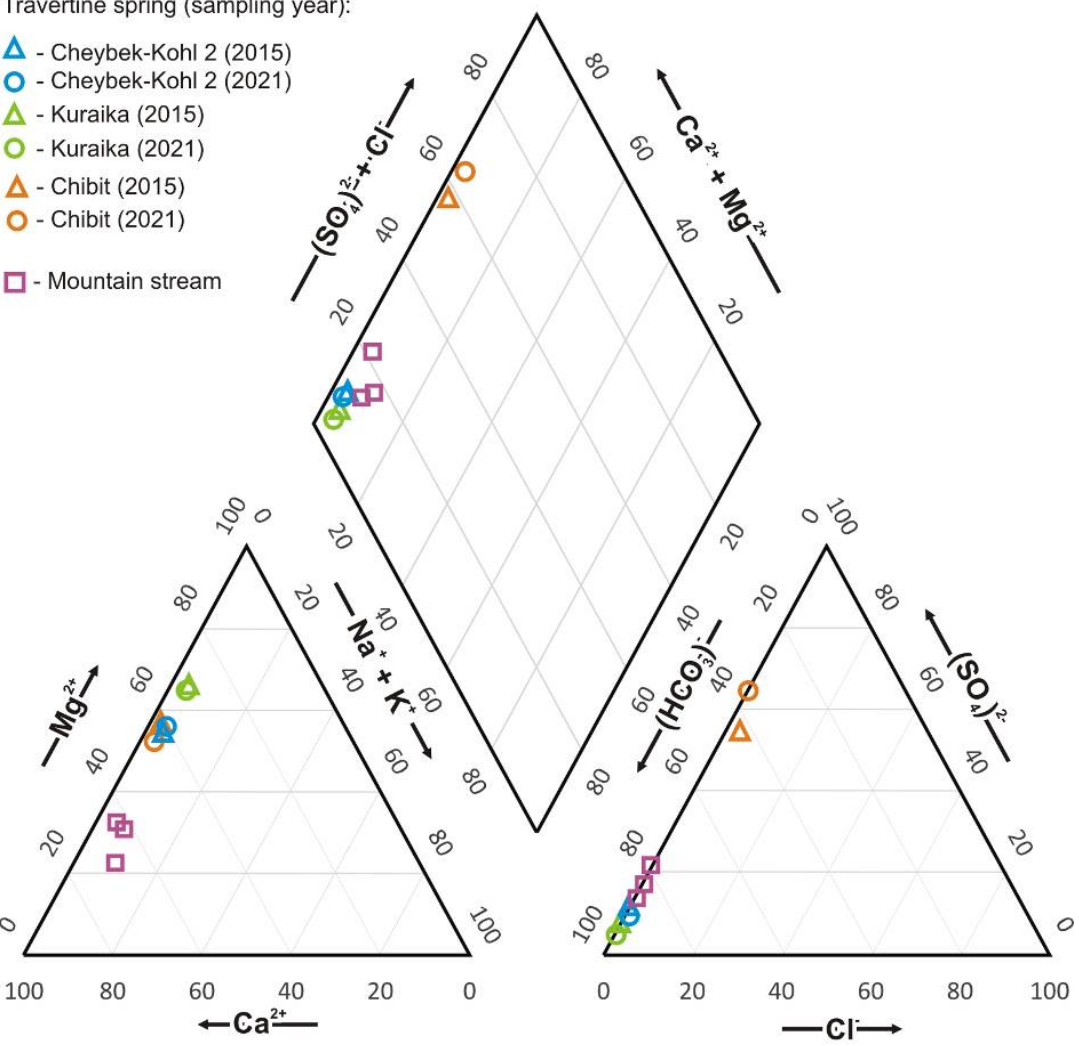
Figure 10. Piper diagram for the travertine spring water (cf. Table 1) and mountain steam water [41] of the south-eastern Gorny Altai.